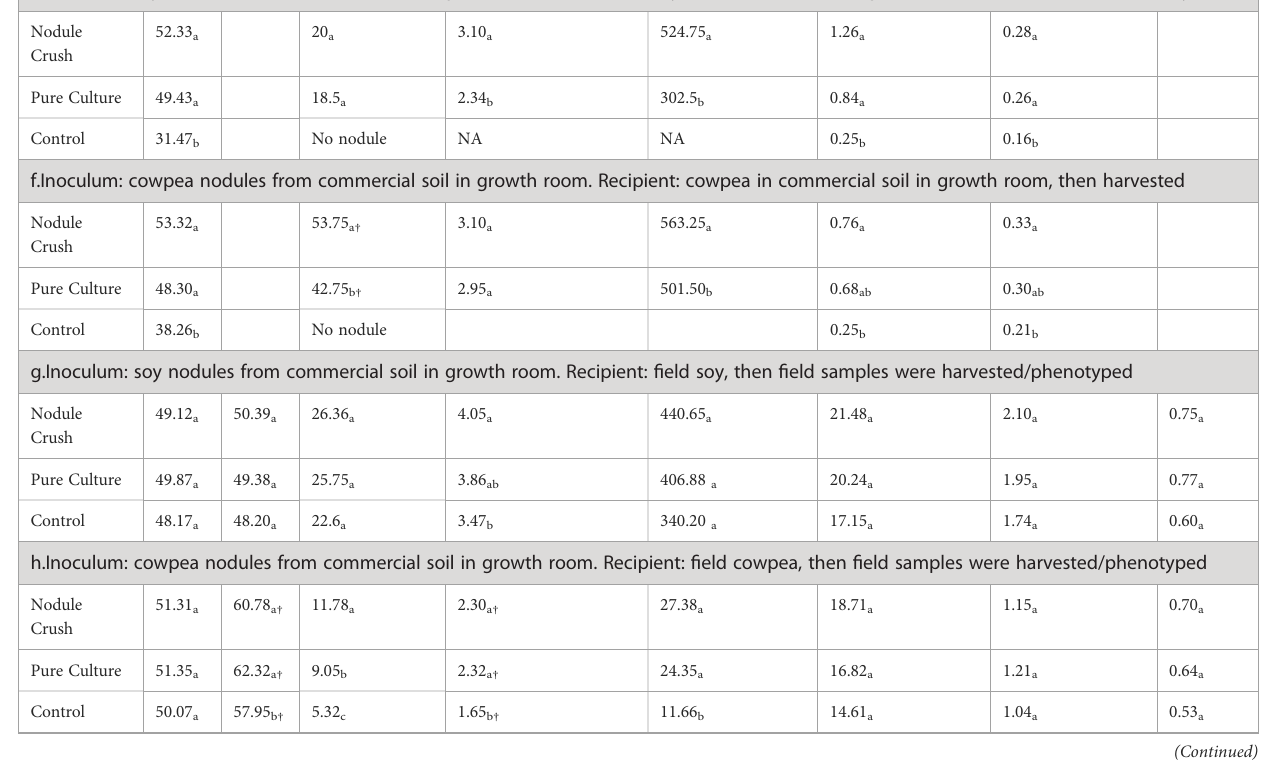
Root dry weight/plant (g)